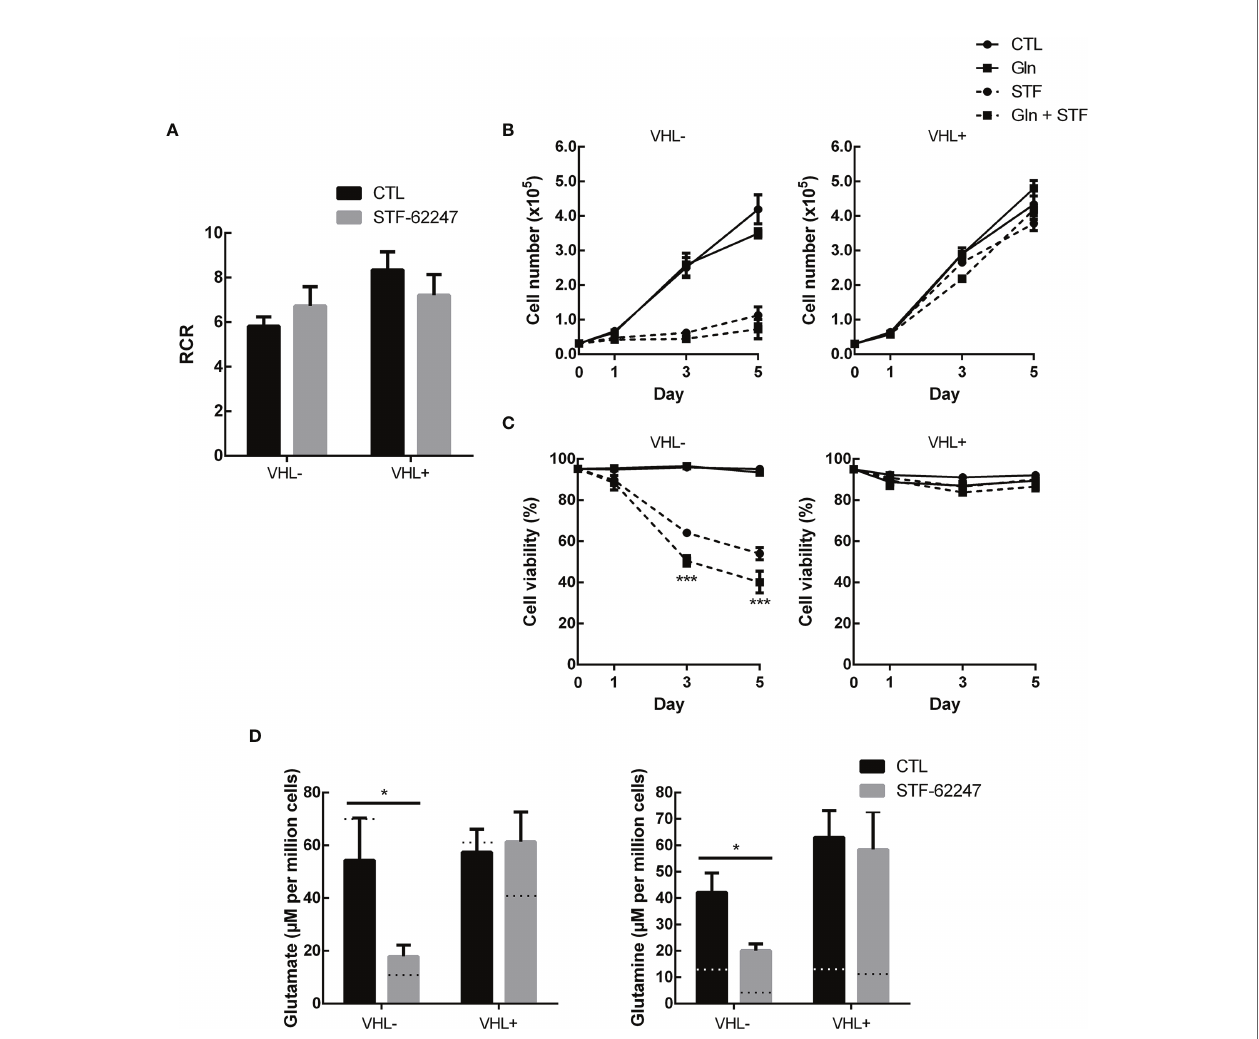
FIGURE 3 | Glutamine excess is not suf fi cient to overcome stress from STF-62247 (A) Respiratory control ratio (RCR) measured with an Oxygraph-2K (Oroboros) in RCC4 VHL- and VHL+ treated with 1.25 µM STF-62247 for 24 hr (N=3). (B) Proliferation and (C) Viability of RCC4 VHL- and VHL+ treated with 1.25 µM STF-62247 and/or an excess of 10 mM glutamine. Cells were counted on days 0, 1, 3 and 5 with trypan blue to evaluate cells viability (N=3). Statistical marks shown in cell proliferation and viability curves are either between CTL and Gln, or between STF and STF + Gln conditions. (D) Intracellular glutamate and glutamine measured by LC-MS in RCC4 VHL- and VHL+. Cells were seeded in media containing 10 mM glutamine and treated with 1.25 µM STF-62247 for 24 hr (N=6). Dotted lines represent values from data obtained from cells incubated in normal media containing 2 mM glutamine (Data from Figure 1C ). Results are presented as means and SEM of at least three independent experiments. Statistical analyses (Two-Way ANOVA followed by Tukey ’ s test) were performed to assess signi fi cant differences in the results (A – D) . (*p <